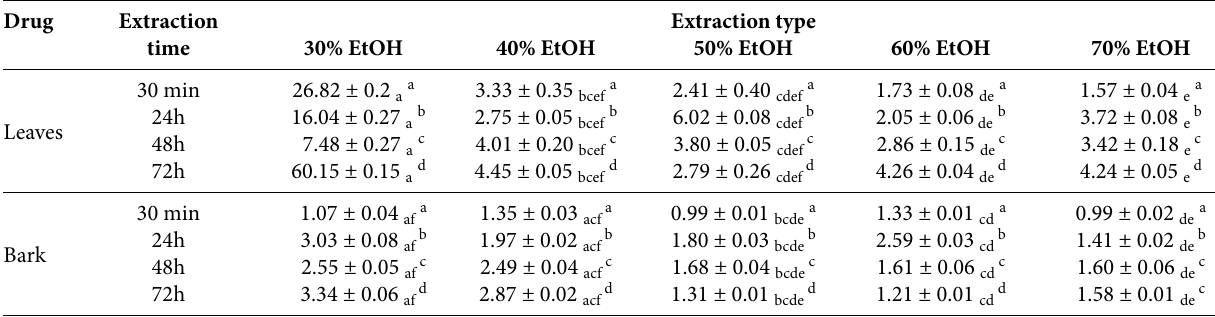
Table 2. Antioxidant activity of S. caprea leaves and bark extracts [µg/ml]